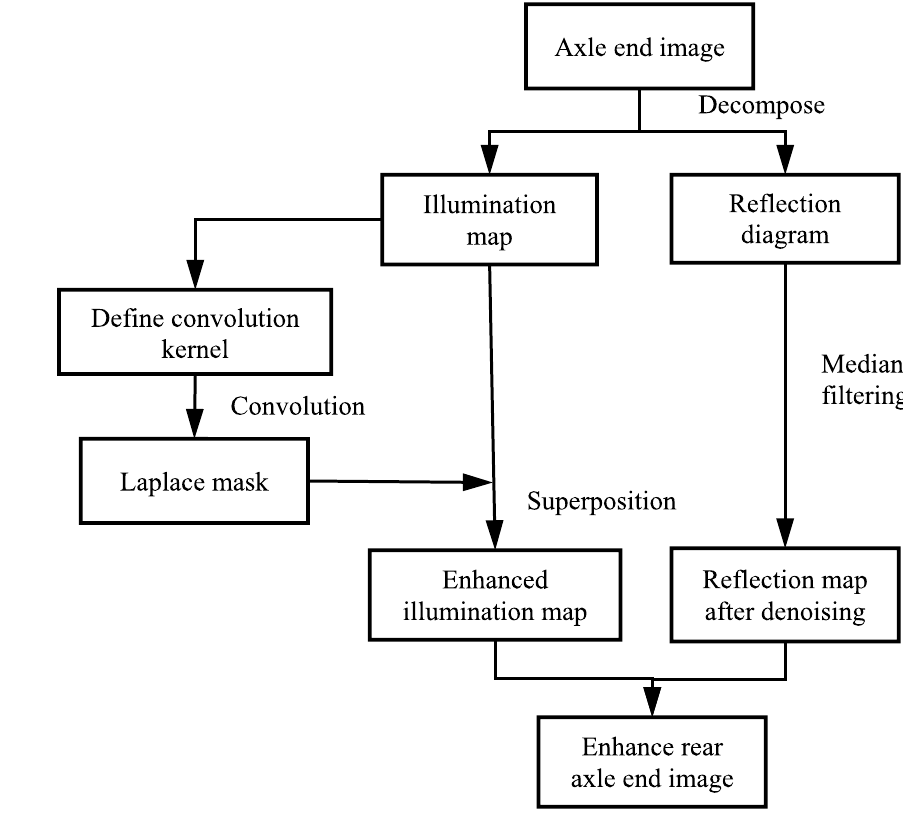
Fig. 10 Flowchart of image enhancement processing